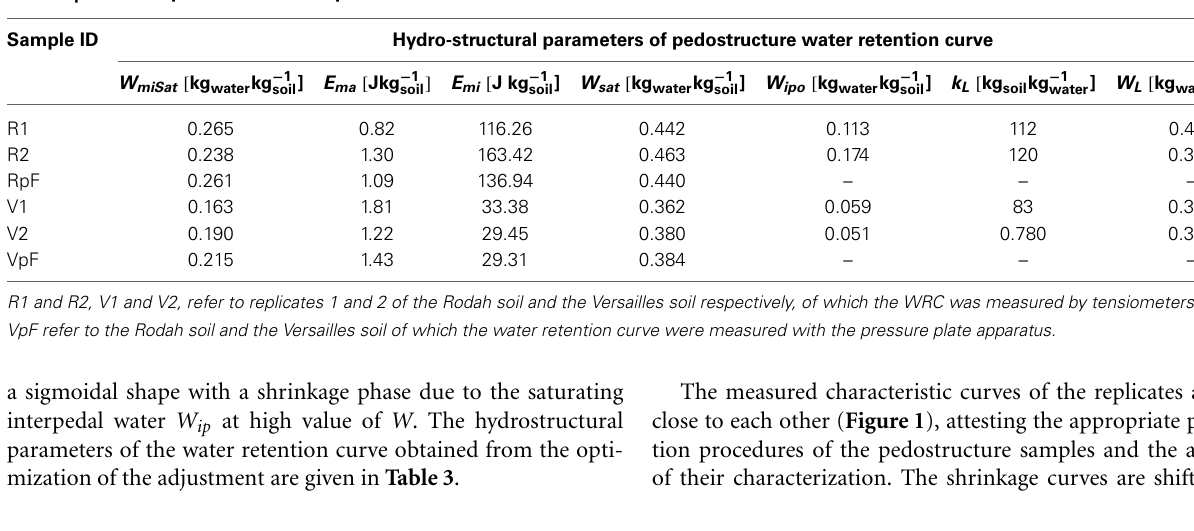
measured shrinkage curve (brown points) for replicate 2; (iii) The measured (blue points with line) and fitted (green) water retention curve (WRC); and (iiii) the measured (brown points with line) and fitted (black line) water retention curve for replicate 2.